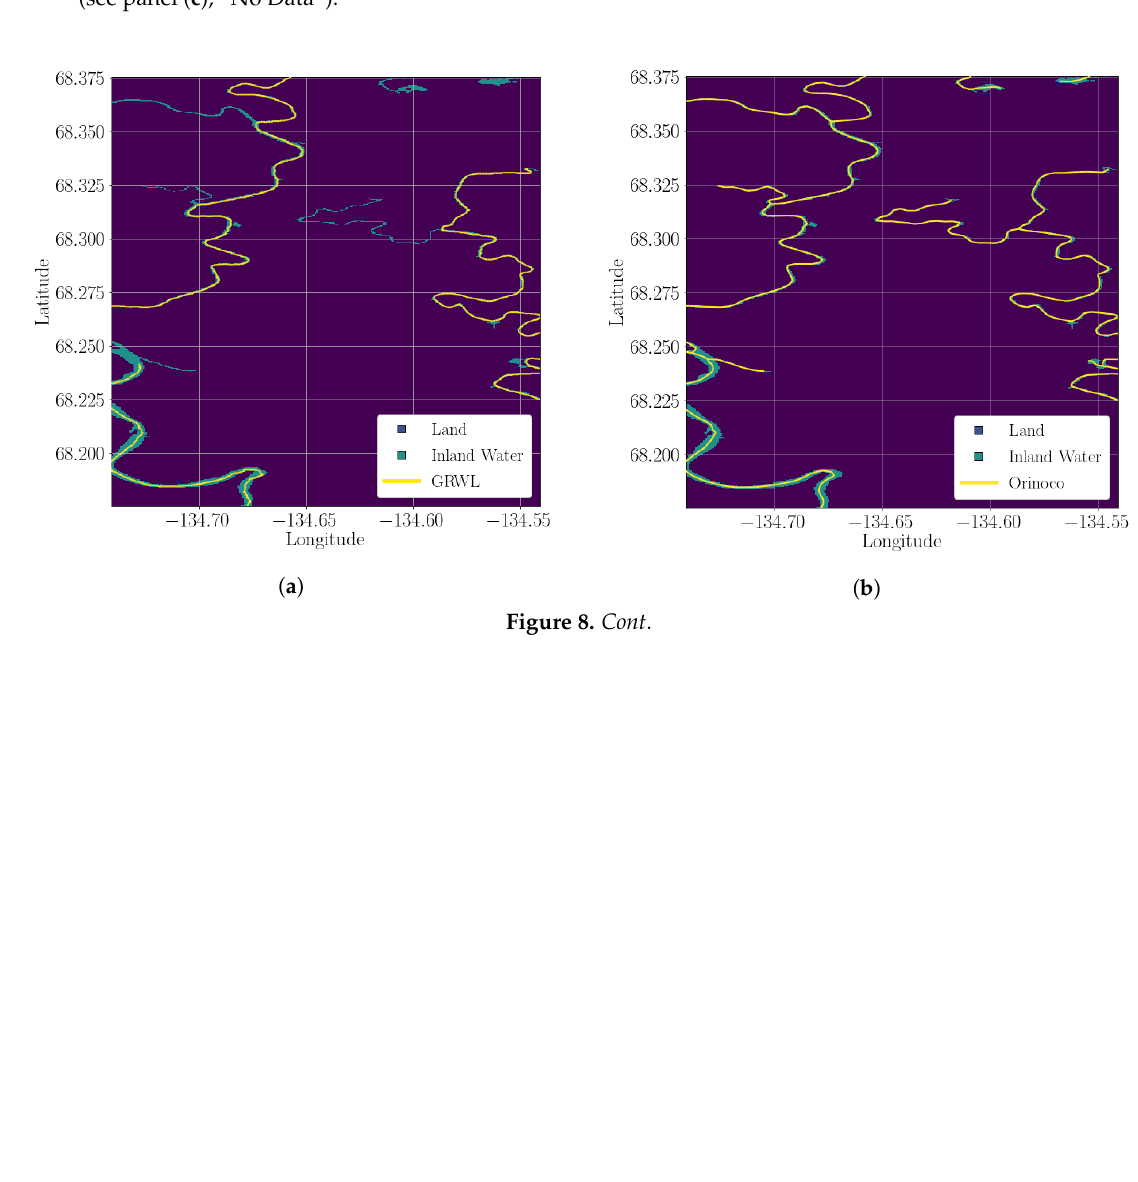
Figure 7. Comparison of GRWL and Orinoco over a subset of the Mackenzie (NR08). Top Row: comparison of channel centerlines and connectivity in ( a ) GRWL and ( b ) Orinoco . Bottom Row: ( a ) is the per segment difference in widths (when applicable) and ( d ) is the histogram of errors. Note that we also have removed segments whose corresponding node in the network is a junction or adjacent to one (see panel ( c ), “No